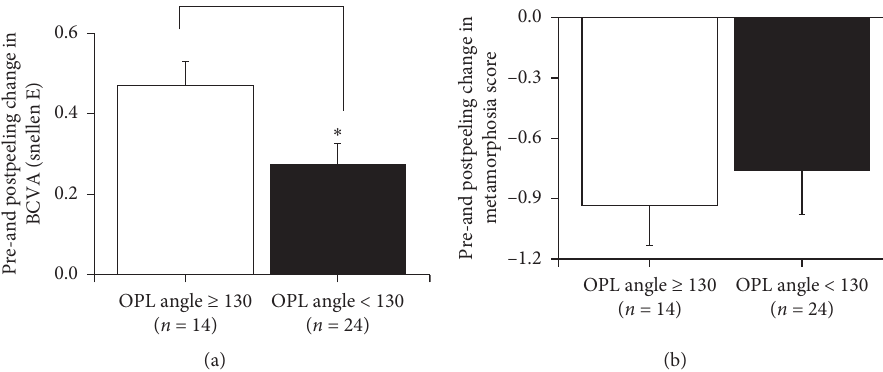
Figure 3: The group of patients’ retinas with greater prepeeling OPL angle ( ≥ 130 ° ) was associated with significant greater BCVA im- provement ( n � 14; 0.47 ± 0.06 � − 0.52 ± 0.07 LogMAR) and greater metamorphopsia reduction ( n � 14; − 0.93 ± 0.20) as compared to the other group of patients whose retinas had smaller OPL angle ( < 130 ° ) with less BCVA improvement ( n � 24; 0.27 ± 0.05 � − 0.29 ± 0.08 LogMAR) and less metamorphopsia reduction ( n � 24; − 0.75 ± 0.22).